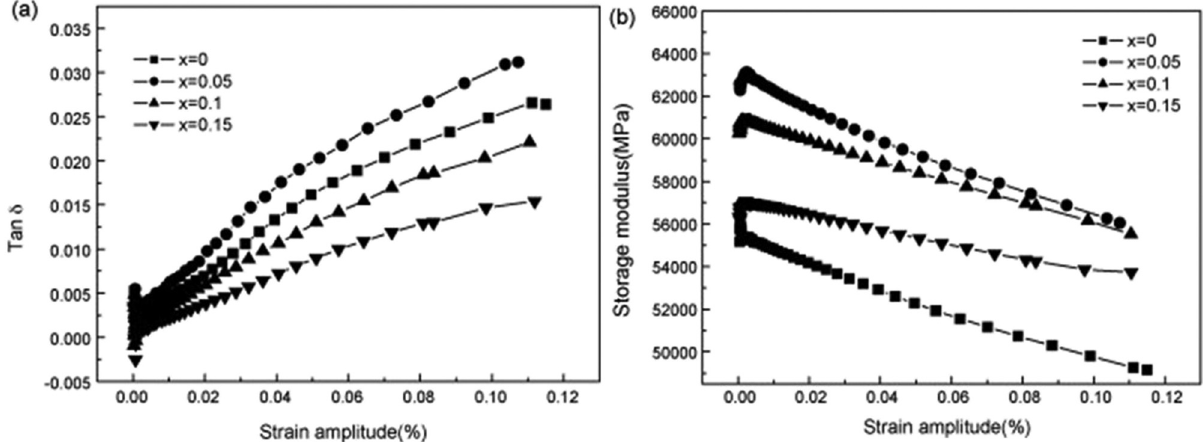
Figure 9: Damping characterization of Cu – 12Al – 5Mn alloys with di ff erent Ce contents: ( a ) the variation trend of tan δ with strain amplitude and ( b ) the variation trend of storage modulus with strain amplitude [ 86 ]